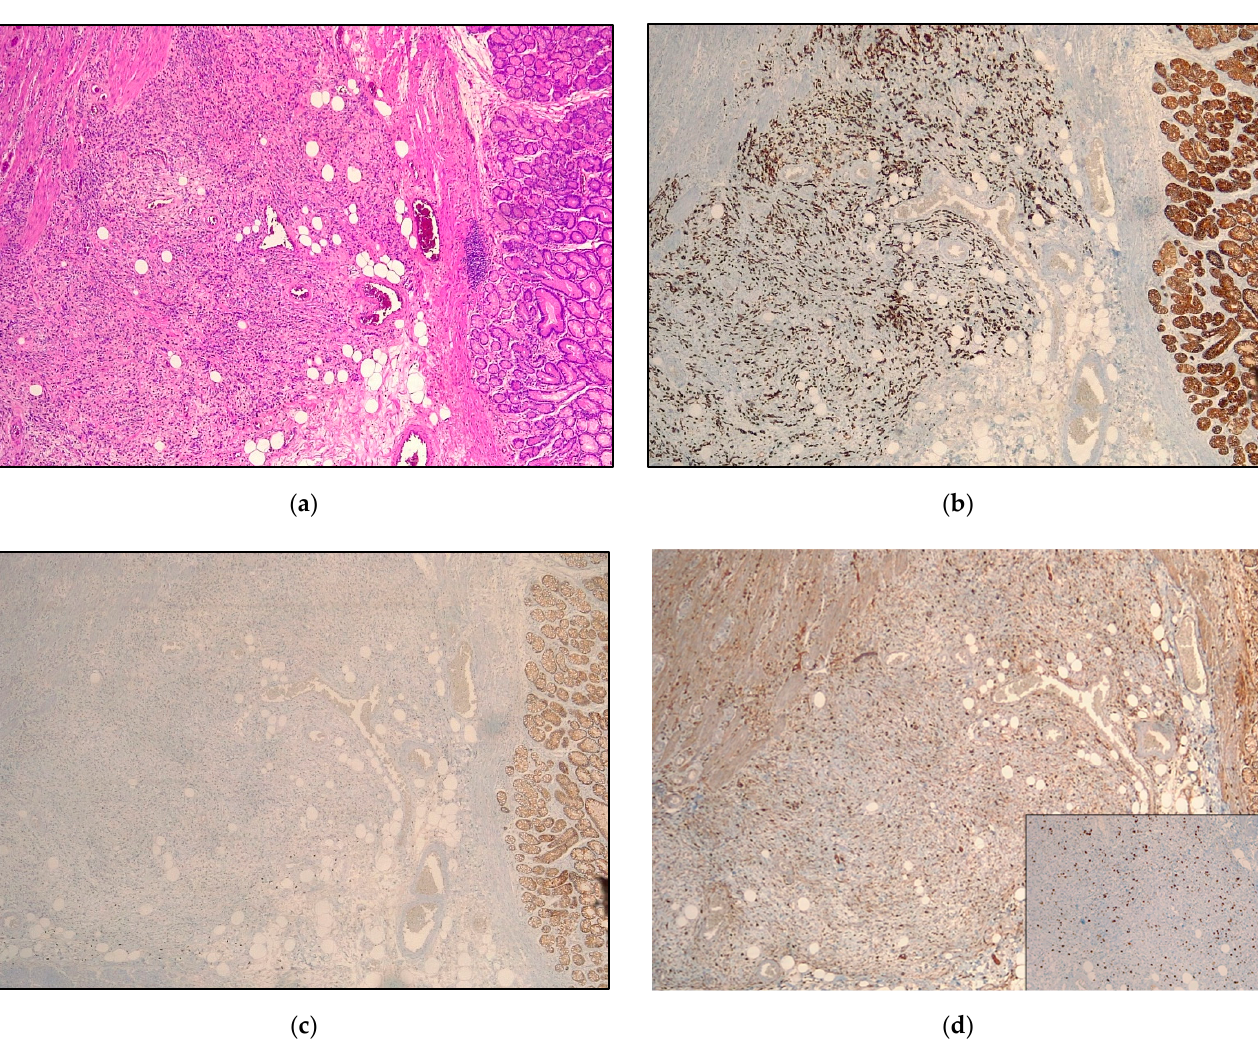
Figure 1. Representative samples of positivity for epithelial-to-mesenchymal transition markers: ( a ) A poorly cohesive signet ring cell phenotype (acc. to WHO) or diffuse type (acc. to Lauren) infiltrating the muscular layer is presented; ( b ) a 8/18 cytokeratin stain confirming the epithelial origin of the neoplastic proliferation is shown; ( c ) E-cadherin negativity of neoplastic cells is depicted; the positive control is represented by the normal gastric epithelium on the right side expressing E-cadherin; ( d ) neoplastic cells show membranous positivity for CD44 and nuclear expression of Zeb-1 (inset, bottom right) in more than 10% of cells. ( a ) Hematoxylin and eosin; ( b ) CK8/18 stain; ( c ) E-cadherin stain; ( d ) CD44 stain; inset on the bottom right, Zeb-1 stain. Original magnification (OM): ( a – d ), 4 × ; ( d ), inset, 10 ×